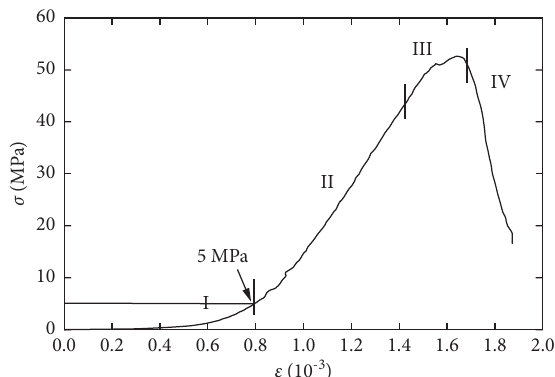
Figure 3: Stress-strain curve segmentation of high-porosity